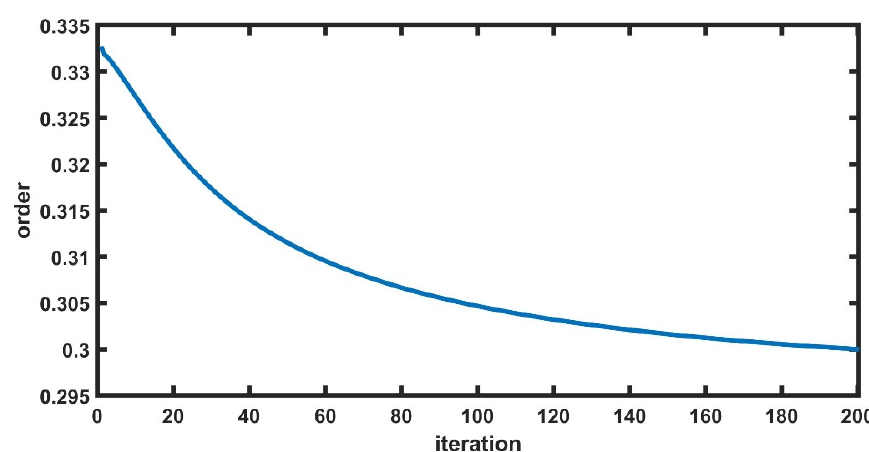
Figure 8. The estimated fractional-order convergence curve.